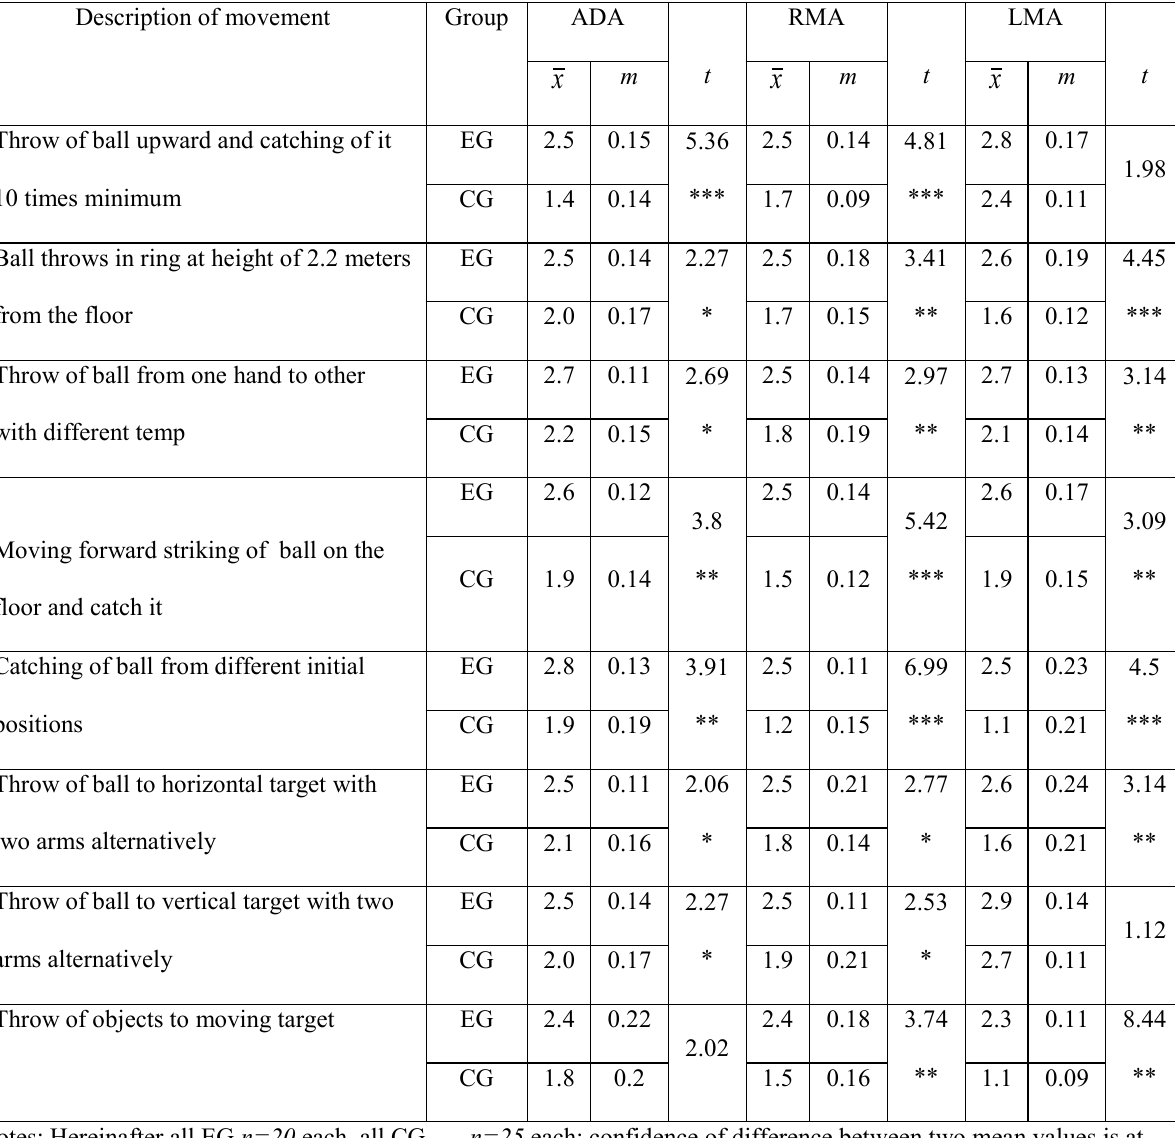
Level of manual motor skills of girls with different MMA orientation during all experiment (points) Description of